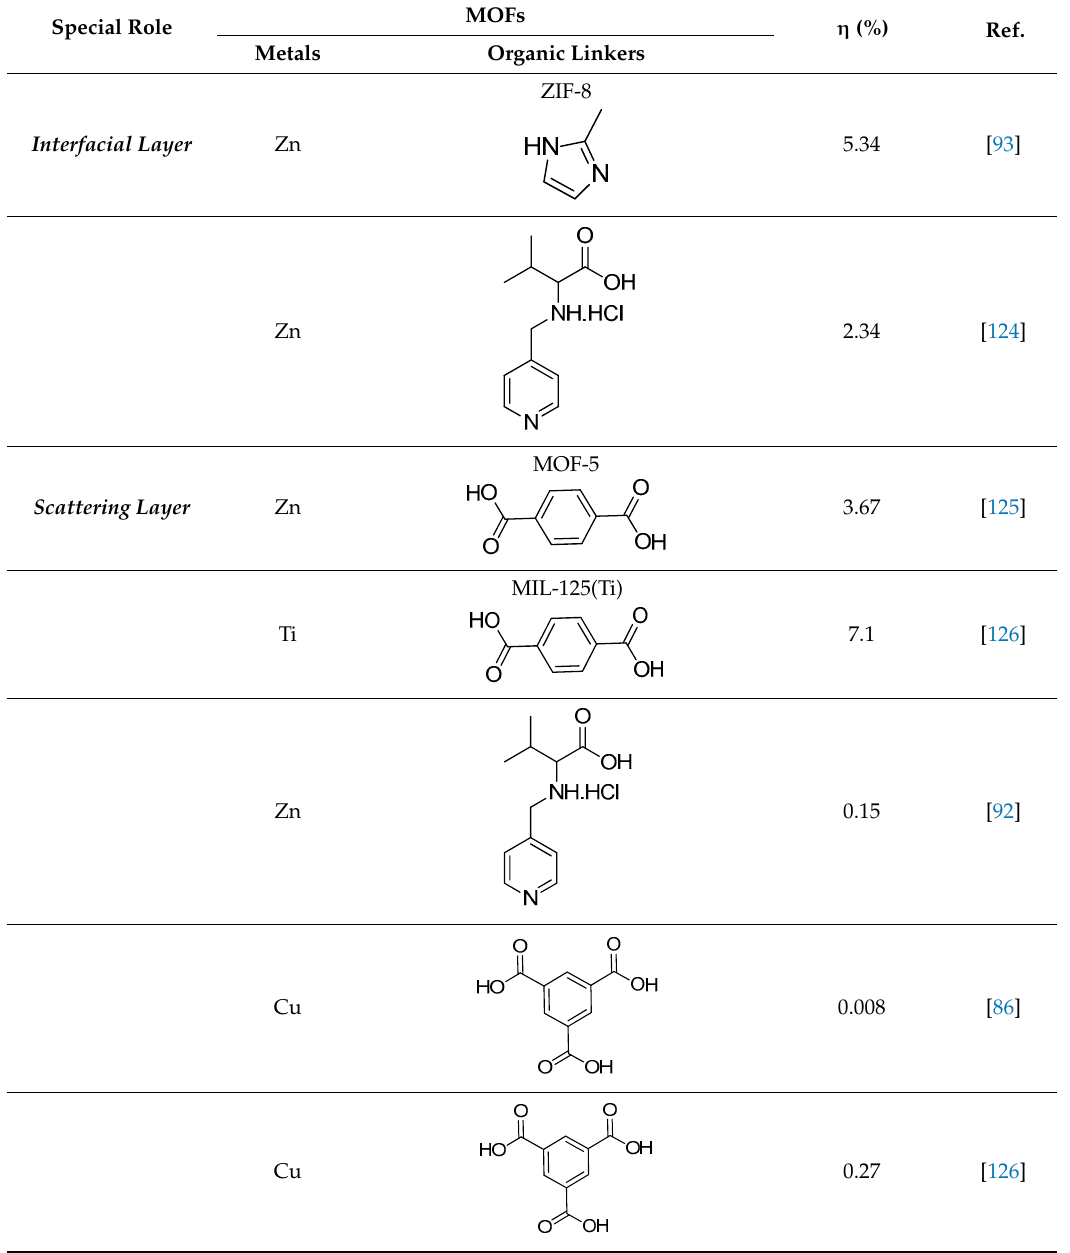
Table 1. List of MOFs effectively employed as photoelectrodes in DSSC. For sake of brevity, the SBUs of the MOF (i.e., metal and the organic linker) are indicated separately. Note that the reported values of photoconversion efficiency cannot be compared to each other, even though they could shine light on the potentiality of this class of material.